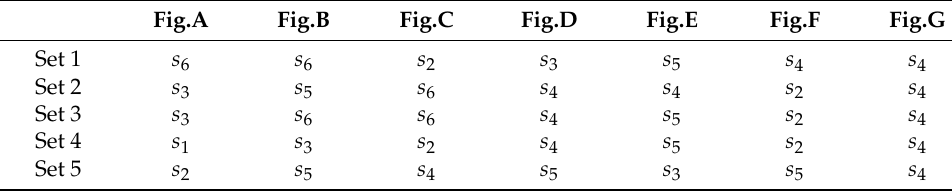
Table 2. Answers for calibration experiment of DM 2 .